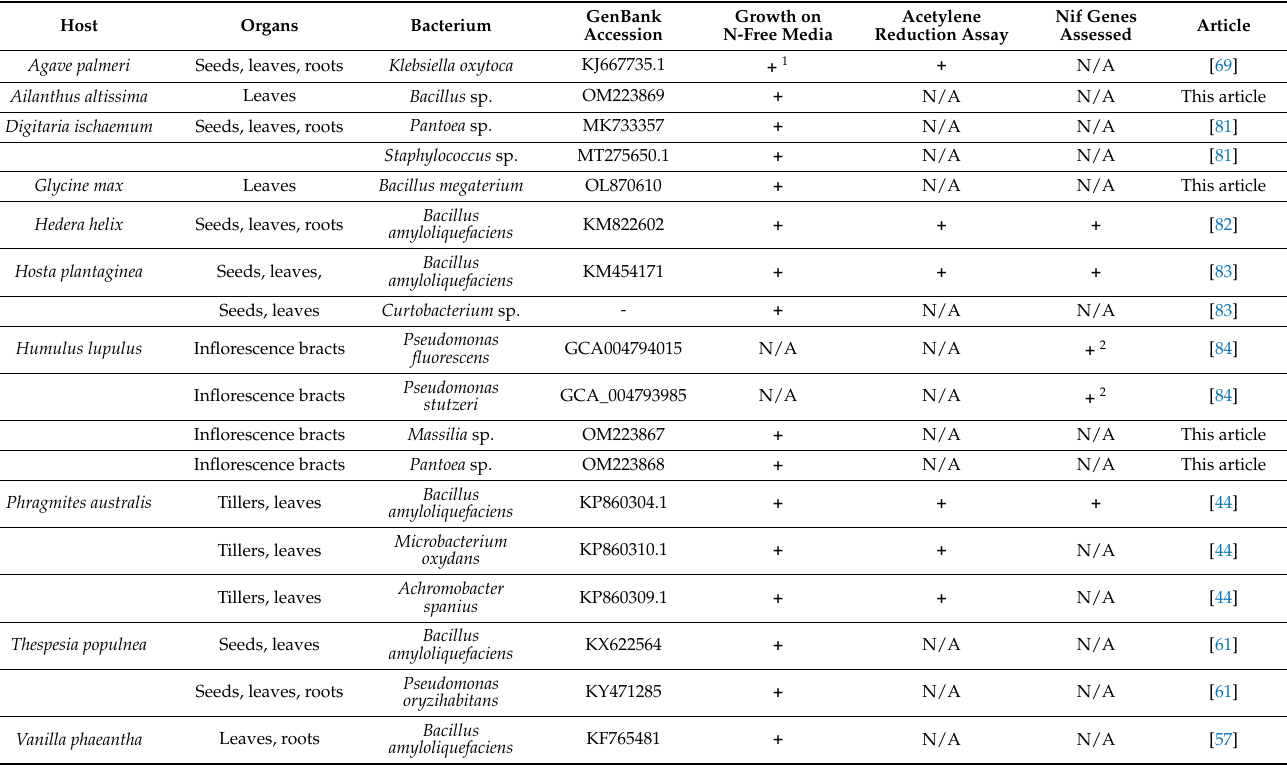
Table 3. Bacteria isolated from plants with leaf cell